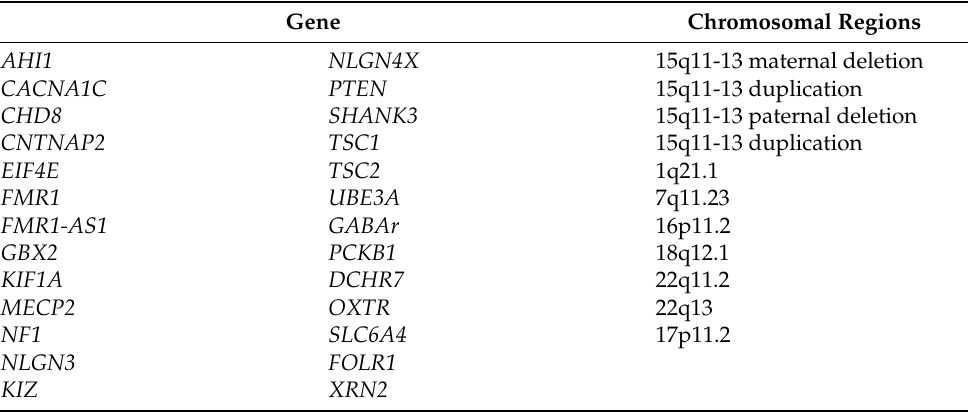
Table 1. Manual review of variants in known, well-established ASD risk genes or chromosomal region deletion/duplication. Gene Chromosomal